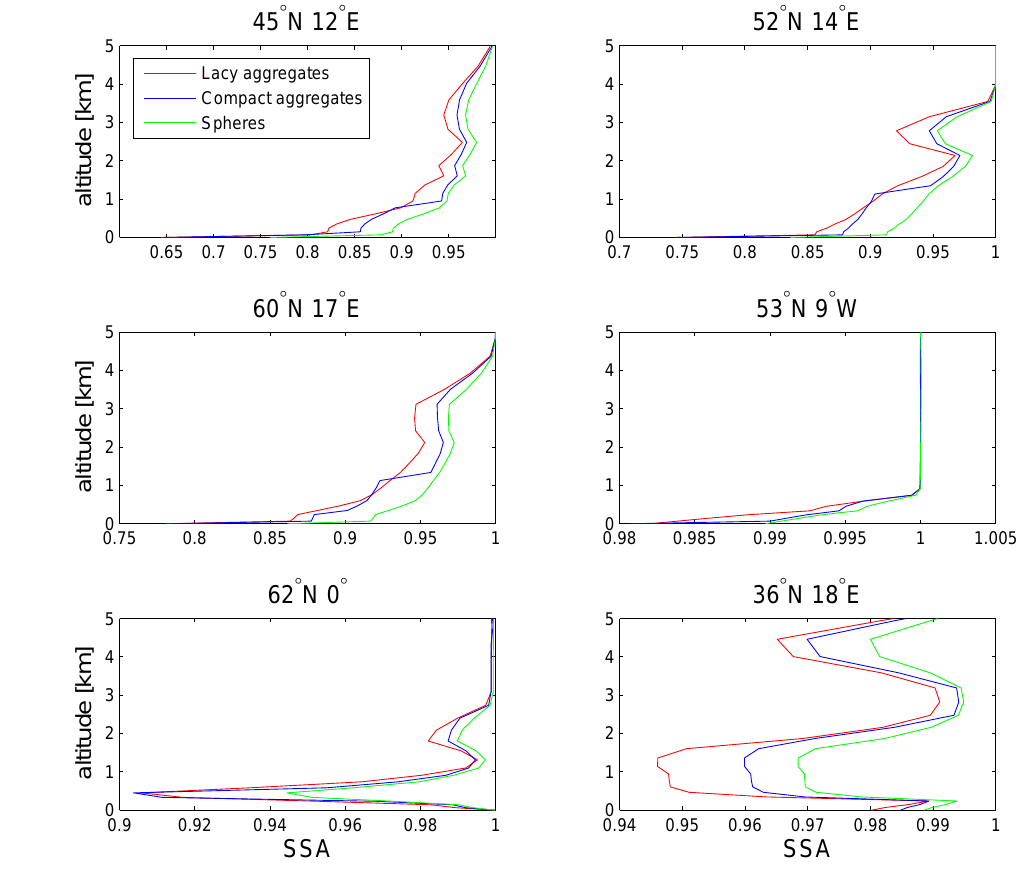
Fig. 5. As Fig. 4, but for the single scattering albedo.